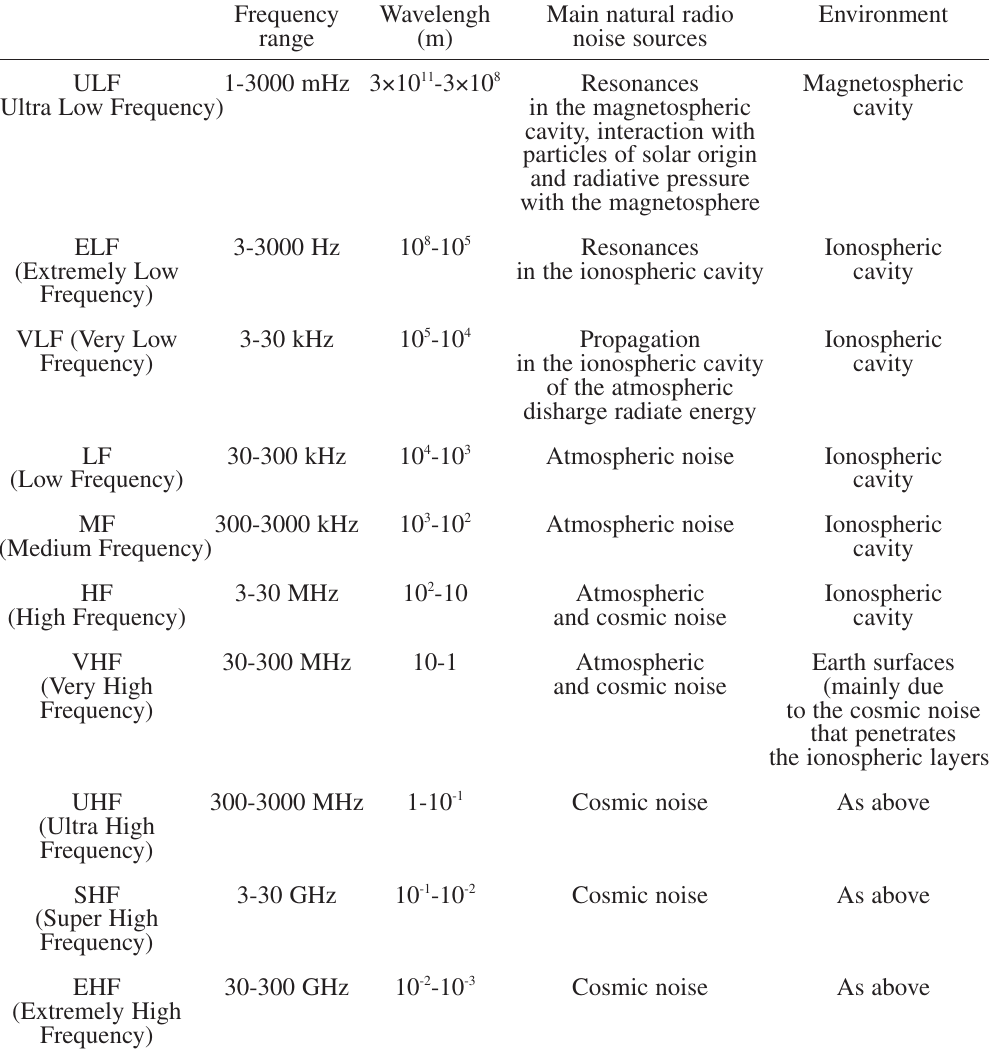
Table I. NIR frequency bands and the main natural radio noise